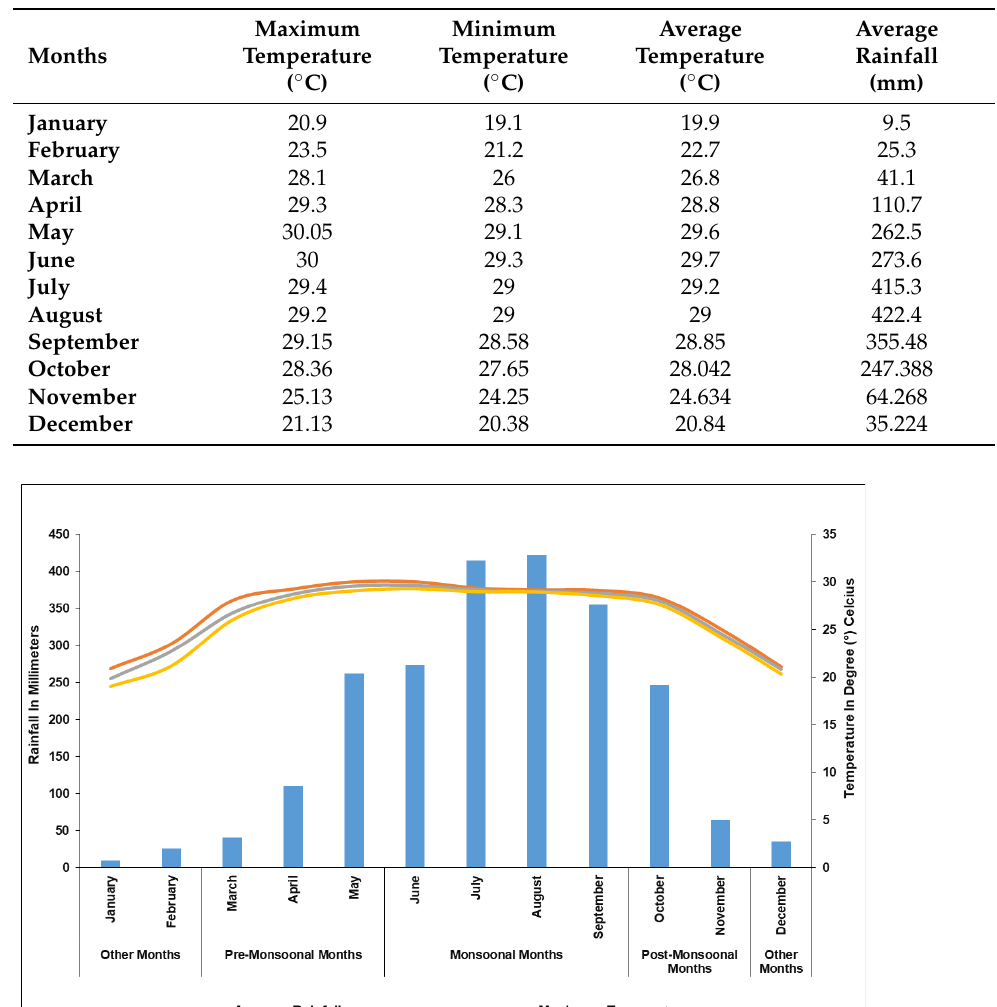
Table A1. Monthly temperature and precipitation statistics of Delta Sub-basin (2017 – 2021). Data Source: IMD.